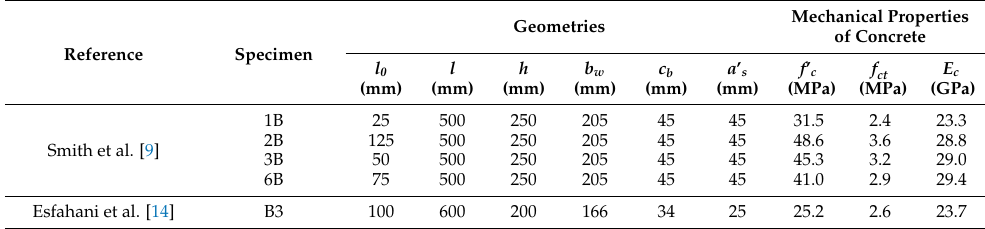
Table 1. Geometries and material properties of beam specimens.